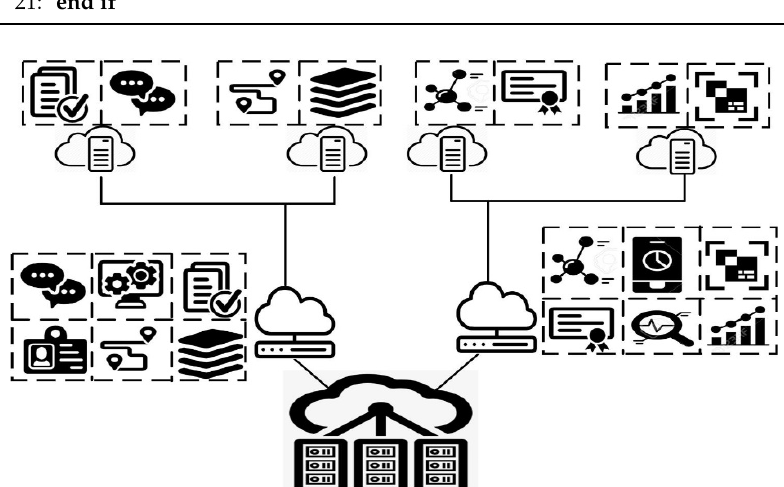
Figure 3. Main levels of the developed fog-MEC scheme.